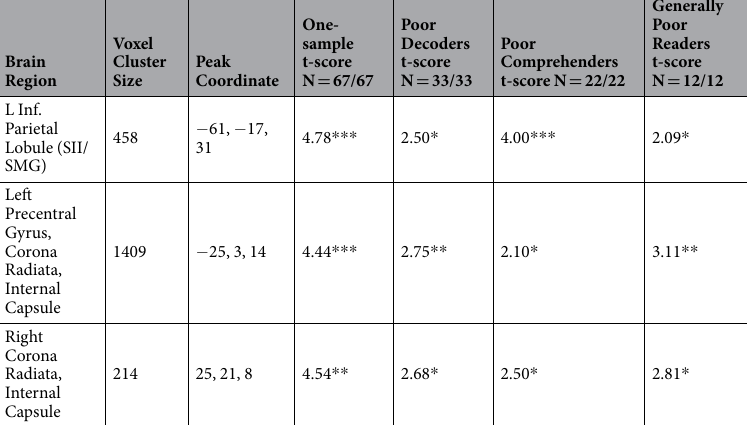
Table 1. Summary of the matched-pair brain morphometry results ( p < 0.05 multiple comparison corrected) and contribution from each reading disability profile. * p < 0.05, ** p < 0.01, *** p < 0.001; t-scores are for the average difference in Jacobian determinant across each cluster shown in Fig. 1. N = #/# indicates the number of cases and controls in each analysis. These Jacobian determinant effects were not due to case-control differences in Perceptual Reasoning. For example, the association between case-control differences in the left motor region of interest and Perceptual Reasoning differences was r (65) = 0.04,